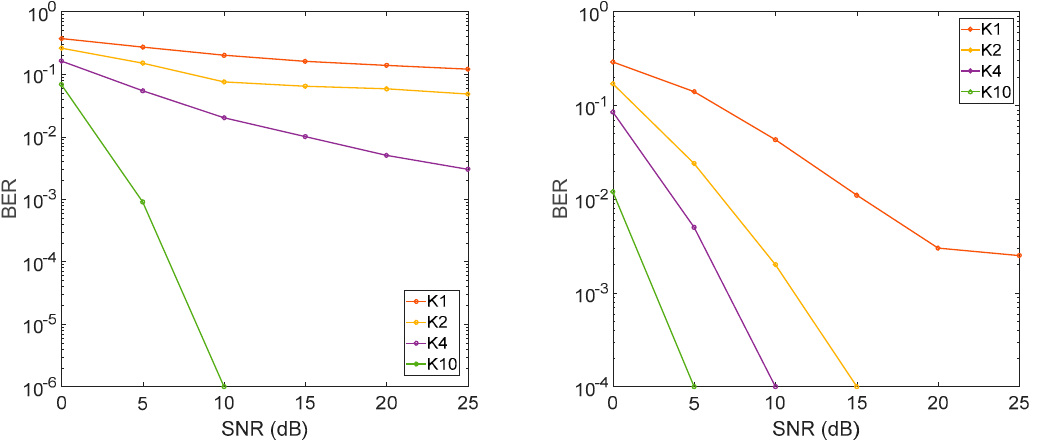
Figure 5. BER of SNR performance acquired during the numerical simulation for channel responses . (cid:1834) (cid:2869) ((cid:2033)),(cid:4662) (cid:1834) (cid:2868).(cid:2873) ((cid:2033))(cid:4662) . H 0.5 ( ω ) H 1 ( ω ) ,